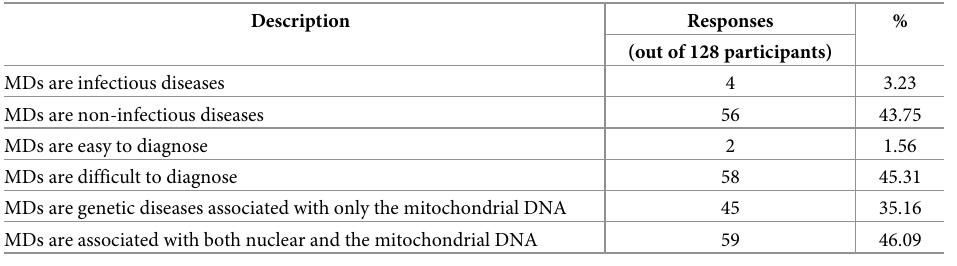
Table 4. General description of